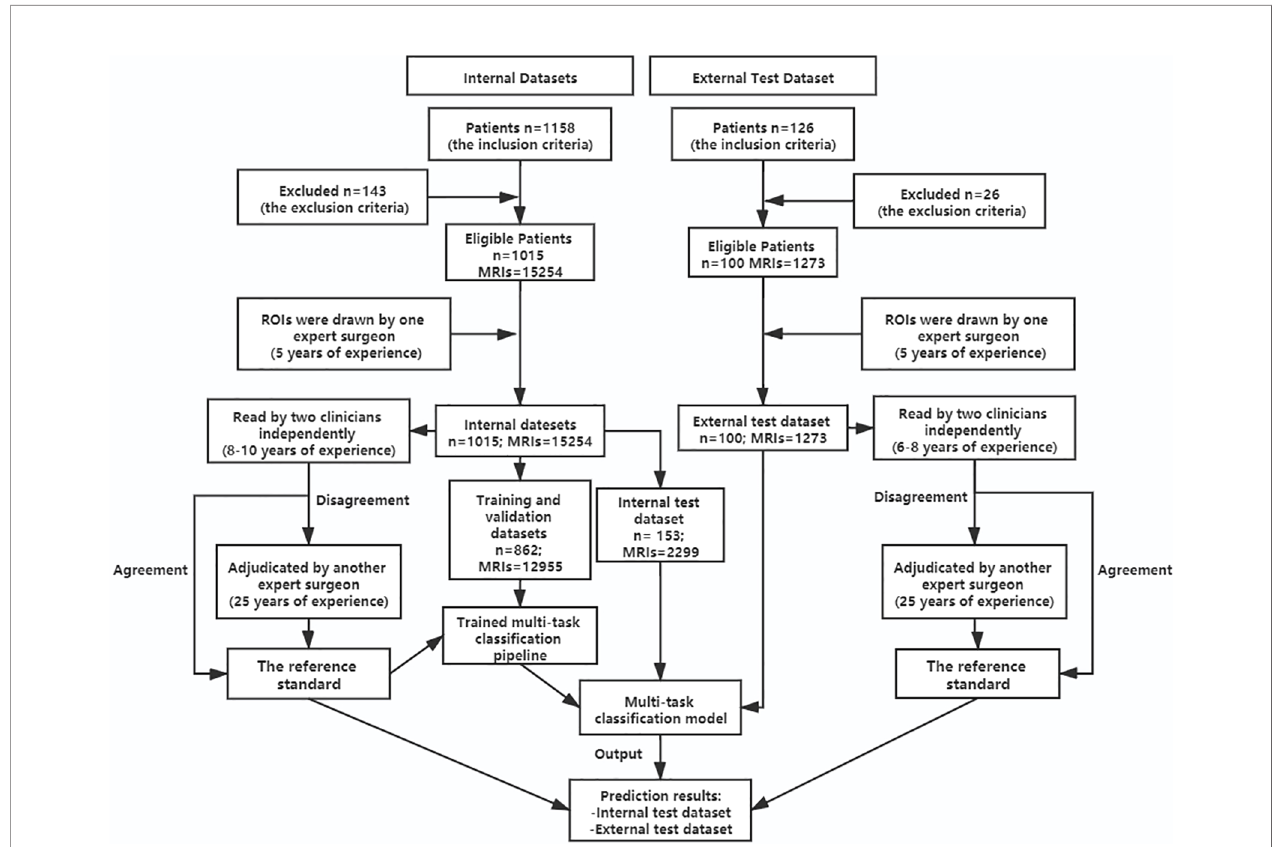
FIGURE 1 | Flowchart showing patients ’ selection for the datasets and the process of training multi-task classi fi cation model. n, number of patients; MRIs, MRI images; ROIs, regions of